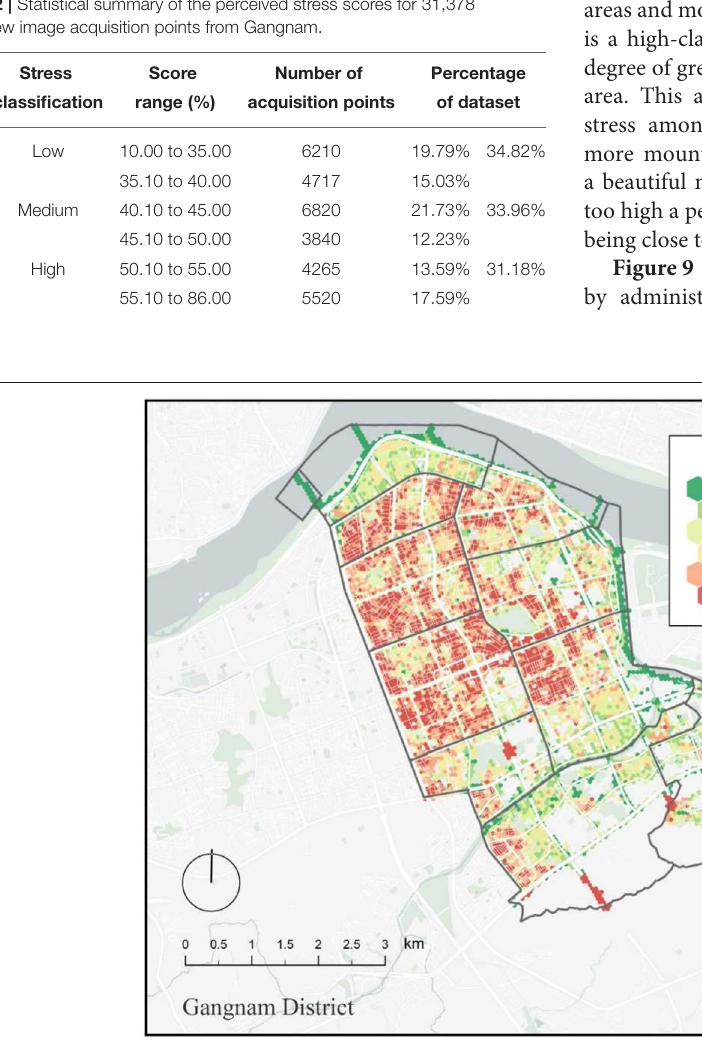
FIGURE 8 | Urban spatial mapping of the perceived stress scores in